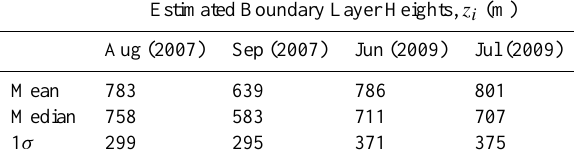
Table 3. Monthly mean, median, and standard deviation of esti- mated atmospheric boundary layer heights for unstable conditions (10:00 ∼ 16:00) during the whole BEARPEX period both in 2007 and